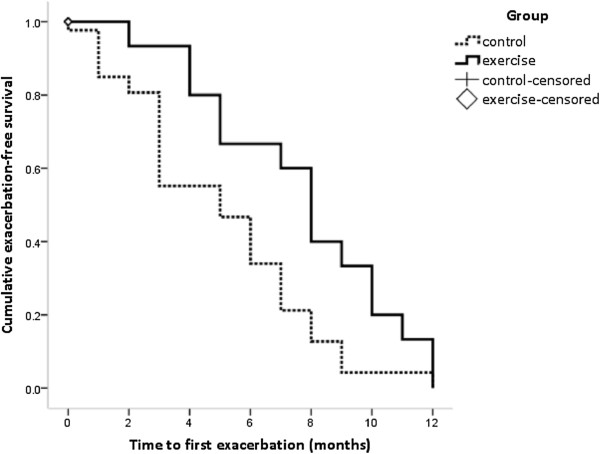
Time to first exacerbation, p = 0.047.